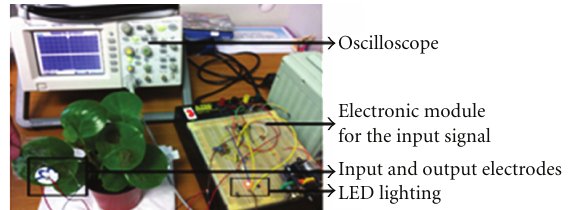
Figure 9: Apparatus for observing the change in action potential when plant is exposed to di ff erent light modes.